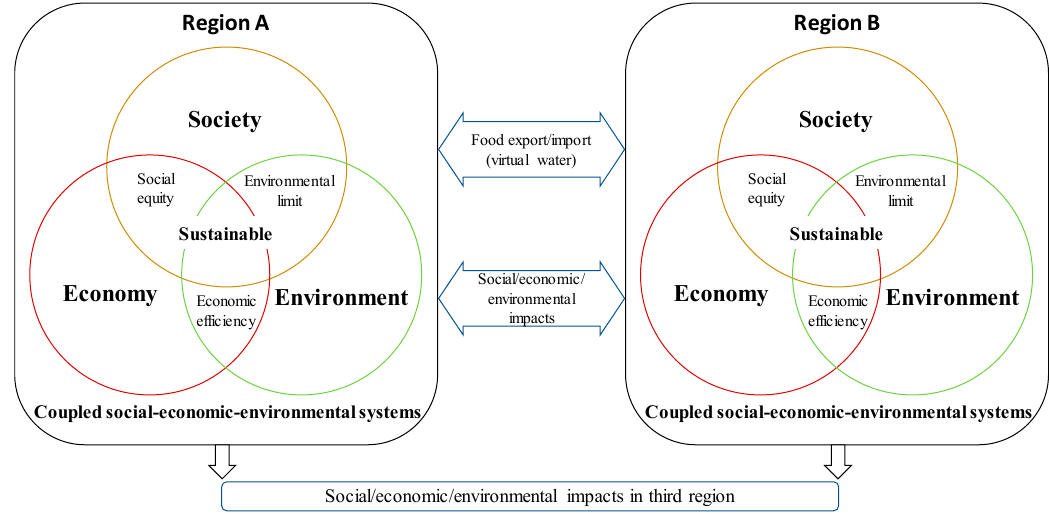
Figure 11. Telecoupling framework for research on virtual water and water footprint.